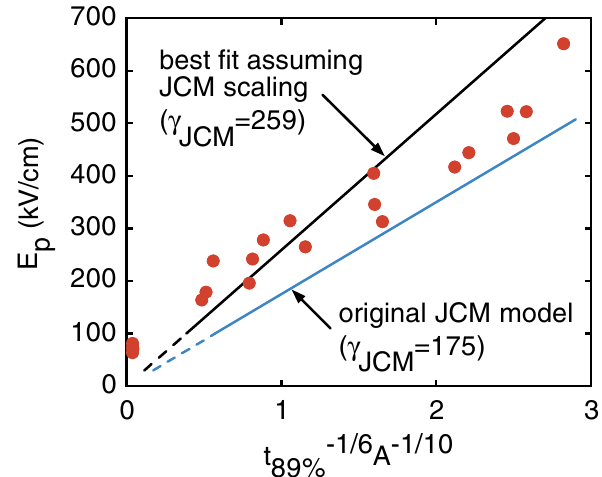
FIG. 6. (Color) The peak electric field E as a function of p A (cid:2) 1 = 10 , which is the JCM scaling, for conditions under t (cid:2) 1 = 6 89% which the flashover probability is approximately 50%. (The is expressed in (cid:11) s , and A in cm 2 .) horizontal axis assumes t 89% The figure plots the 17 PMMA measurements listed in Table I (cid:12) 12 (cid:11) s and 0 : 5 (cid:12) d (cid:12) 4 : 32 cm , and the with 0 : 5 ns (cid:12) t 89% (cid:9) 90 s . This is the same set of four measurements with t 89% measurements used for Fig. 5. The fractional standard deviation for the 17 measurements is 26%. The 90-s in the values of (cid:24) JCM measurements lie close together, and are the only measure- < 100 kV = cm . The model becomes inapplicable ments with E p ! 1 or A ! 1 , which are equivalent to the limit as either t 89% ! 0 , since there exists a minimum electric field below E p which a flashover is not